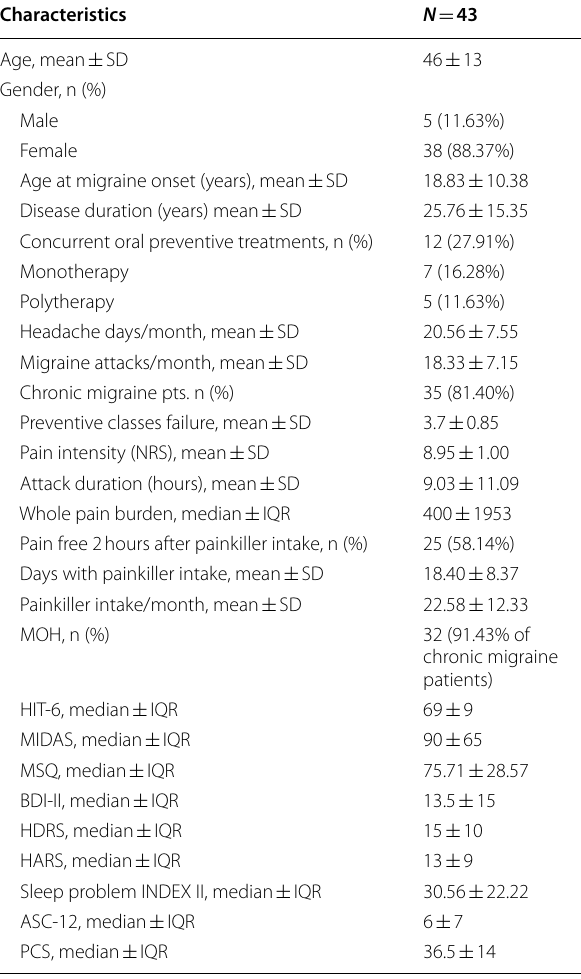
Table 1 Baseline demographic and clinical